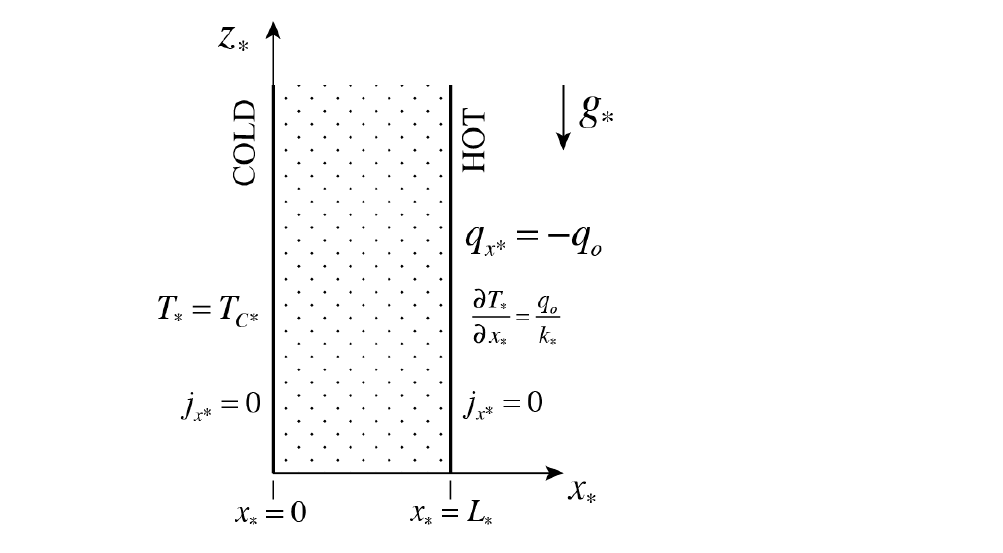
Figure 1. A vertical tall, fluid layer consisting of a binary mixture, heated by a constant heat flux q o > 0 on one side and exposed to a constant low temperature on the other